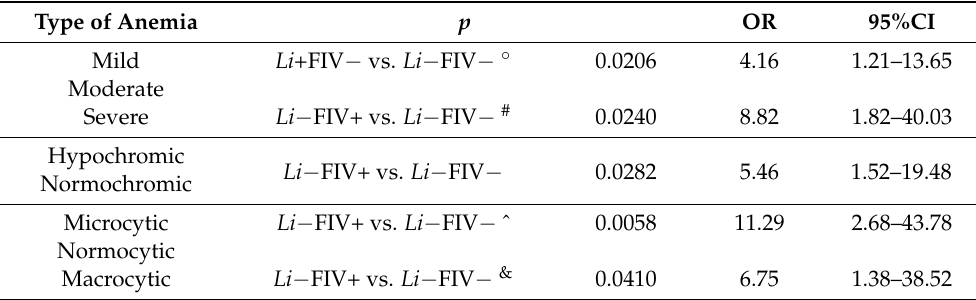
Table 7. p -value, odds ratio (OR), and 95% confidence interval (CI) for the significant differences concerning the types of anemia.